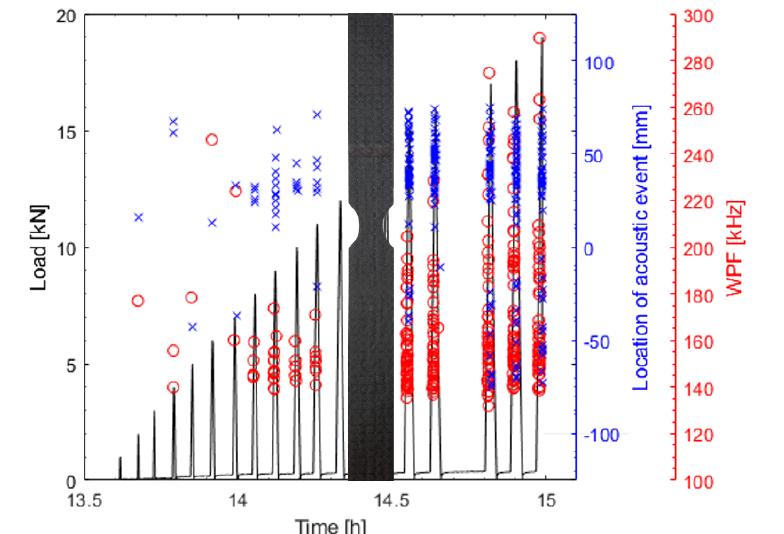
Figure 3. Principle behavior of the specimens during the tensile test. During the beginning of the test, matrix failures occur close to the sensor locations (red dots at lower levels of the WPF). At the end of the test, fiber cracks as well as debonding occur in the area of the notch of the specimen (red dots at high levels of the